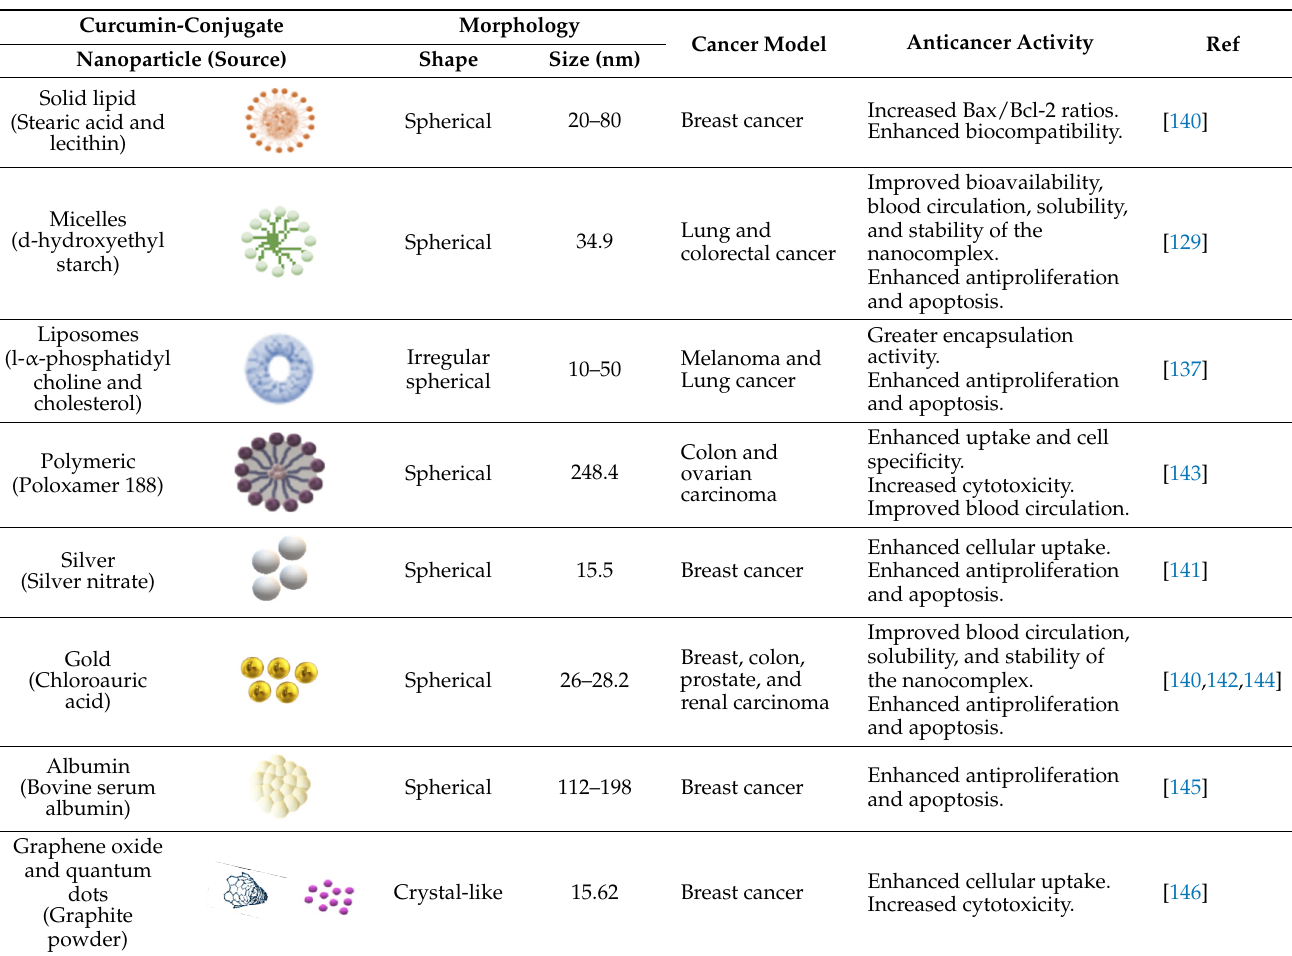
Table 2. Curcumin-conjugated nanoparticles and their anticancer activities. Curcumin-Conjugate Morphology